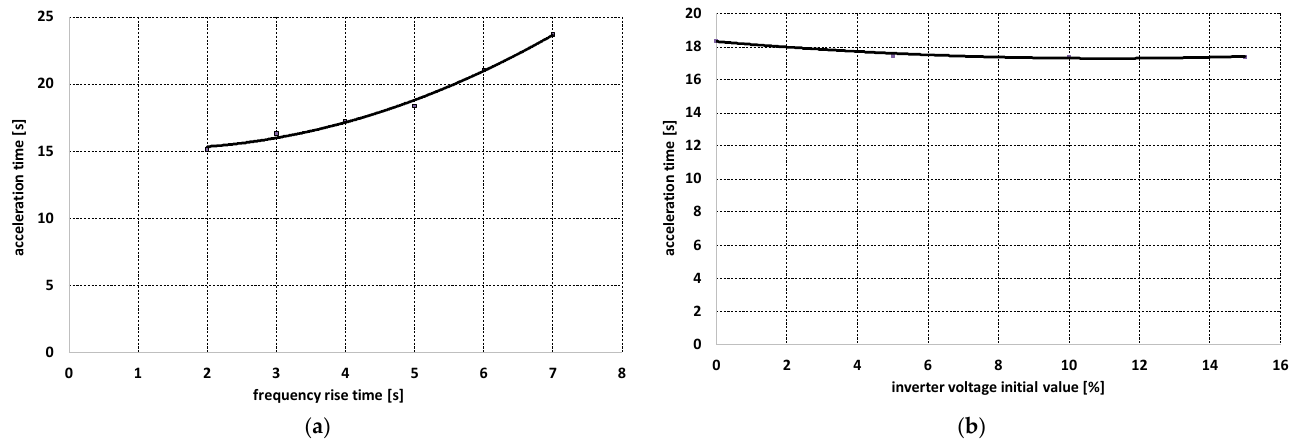
Figure 4. Measured dependence of the rotor acceleration time on the frequency rise time with the initial voltage equal to zero ( a ) and on the inverter initial voltage value for the selected frequency rise time equal to 5 s ( b ).